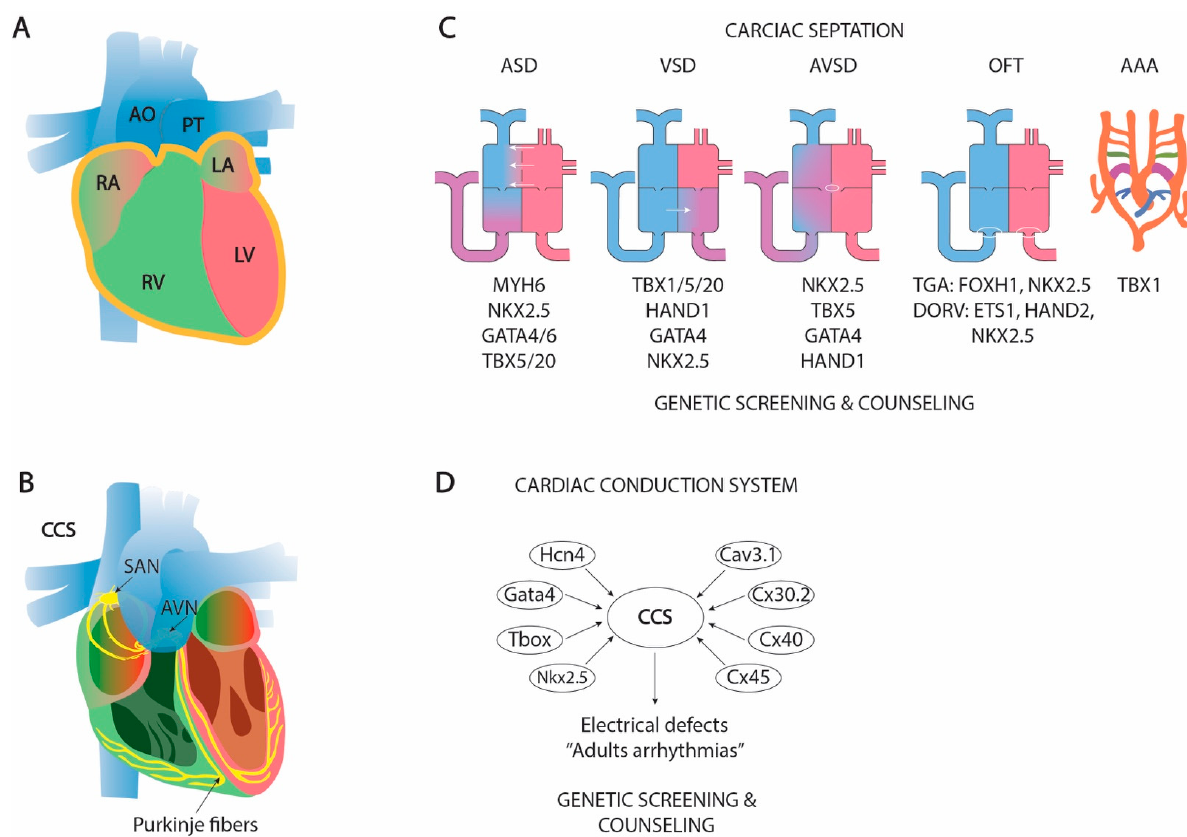
Figure 3. Forming a four-chambered heart. Schematic representation of the fully septated heart ( panel A ), a process that requires multiple players. Impaired expression and or function of any of them leads to congenital heart diseases (CHD) such as atrial septal defects (ASDs), ventricular septal defects (VSDs), atrioventricular ventricular septal defects (AVSDs), conotruncal abnormalities such as double outlet right ventricle (DORV) or transposition of the great arteries (TGA), aortic arch abnormalities (AAA) or even more complex CHD such as Tetralogy of Fallot (TOF) ( panel C ). Understanding of the causative genes have provide tools for genetic screening and counseling ( panel C ) [402–432]. Similarly, our understanding of the cellular and molecular cascades leading to the formation of the cardiac conduction system (CCS) has enormously increased ( panel B ), providing also tools for genetic screening and counseling of CCS abnormalities ( panel D ).